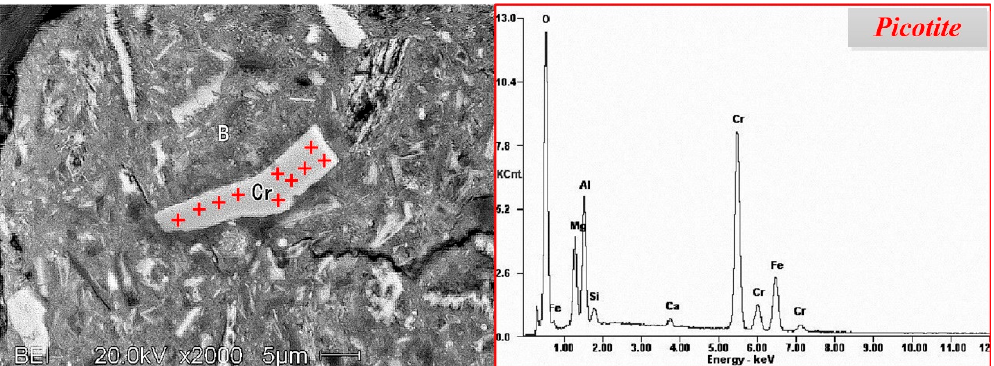
Figure 9. SEM-EDS spectrums of the representative point in the picotite particles. Table 3. Representative chemical compositions of picotite within the slag (wt %). Positions